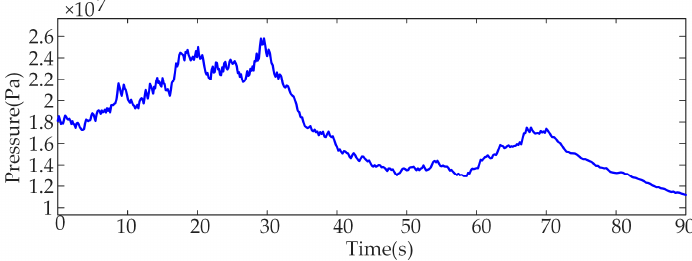
Figure 16. Accumulator pressure under irregular incident waves.